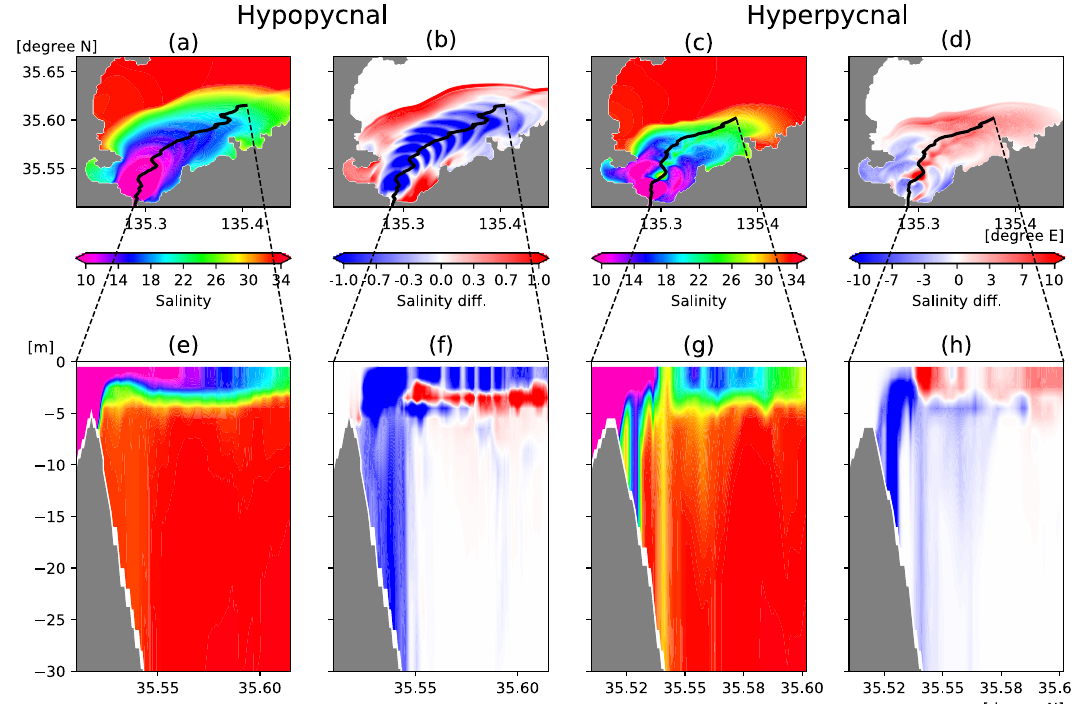
Figure 6. ( a ) Surface (the top two layers) mean distributions of salinity in the typical hypopycnal plume case at 16:00 LT on September 16. ( b ) As ( a ), but for the salinity difference from WOS. ( c ) As ( a ), but for the typical hyperpycnal plume case at 12:00 LT on September 16. ( d ) As ( c ), but for the salinity difference from WOS. ( e ) Vertical salinity distribution along the center section of the river plume indicated by the black line on ( a ). The black line is the main streamline of the riverine output flows determined by the SSM concentration, the flow speed, and the sea surface height maxima. ( f ) As ( e ), but for the salinity difference from WOS. ( g ) As ( e ), but for the typical hyperpycnal plume case. ( h ) As ( g ), but for the salinity difference from WOS. Note that the blue–red color scale of salinity differences differs by one order of magnitude in the hypopycnal and hyperpycnal cases. This figure was prepared with matplotlib ver. 3.3.1 in Python ver.